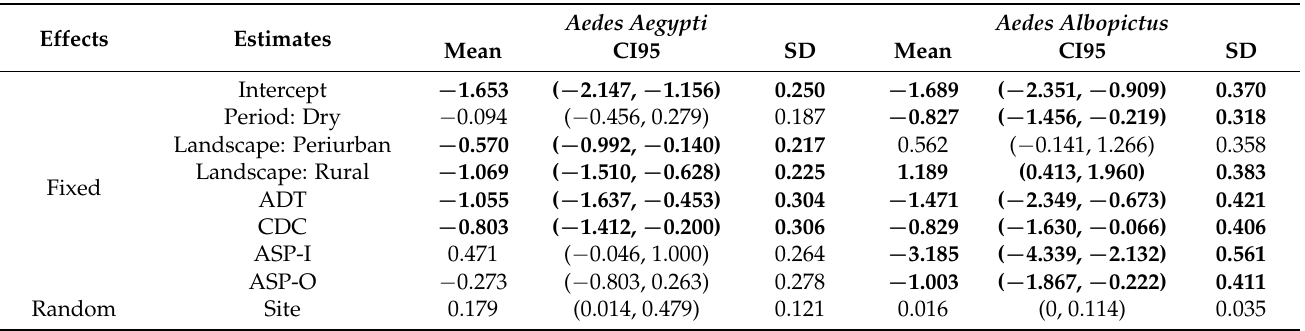
Table 2. Estimates, credibility interval (CI95%), and Standard Deviation of the GLMMs for Ae. aegypti and Ae. albopictus . Bold entries indicate statistical